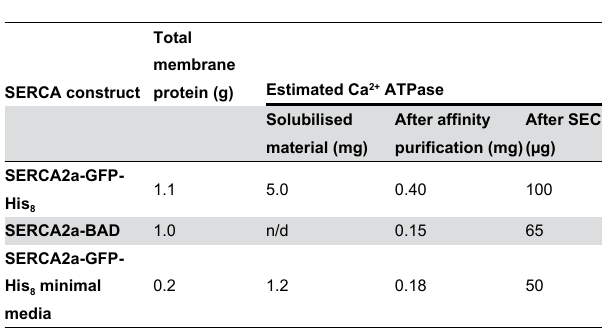
Table 1. Human cardiac SERCA2a protein yield obtained per 1L of culture S. cerevisiae using minimal and rich